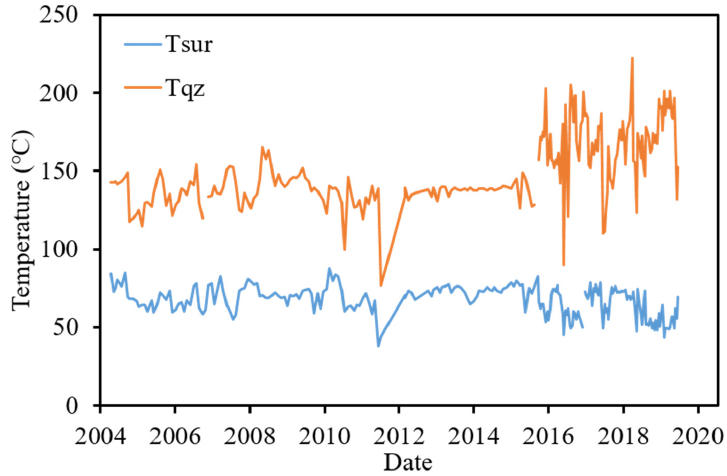
Figure 7. Surface and quartz geothermometer temperature time series of TYK thermal